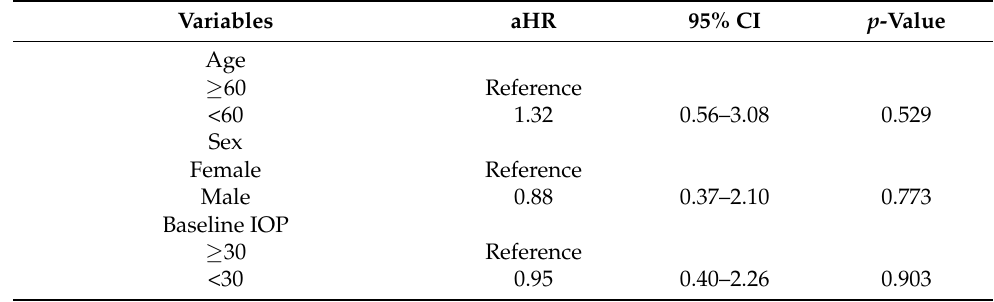
Table 5. Univariate Cox proportional hazards models to investigate the significant independent predictors of treatment